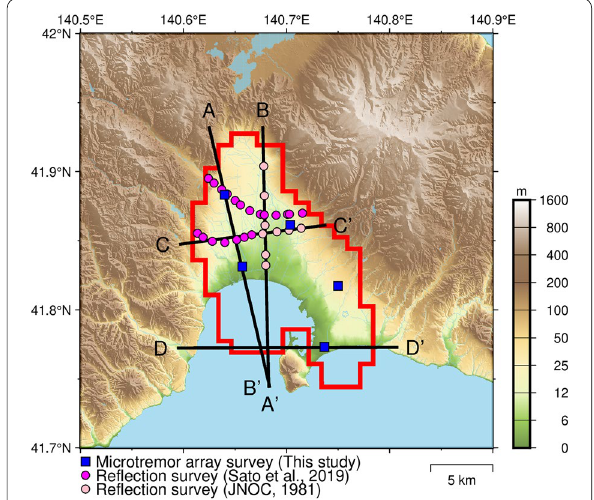
Fig. 5 Target area for modeling velocity structure in the Hakodate Plain. The target area for constructing the new velocity structure model (red frame) and locations of control points (blue: microtremor array surveys, magenta: reflection surveys by Sato et al. (2019), pink: reflection surveys by Japan National Oil Corporation (JNOC) 1981) are shown. The black lines correspond to the profiles for the vertical cross sections shown in Fig.